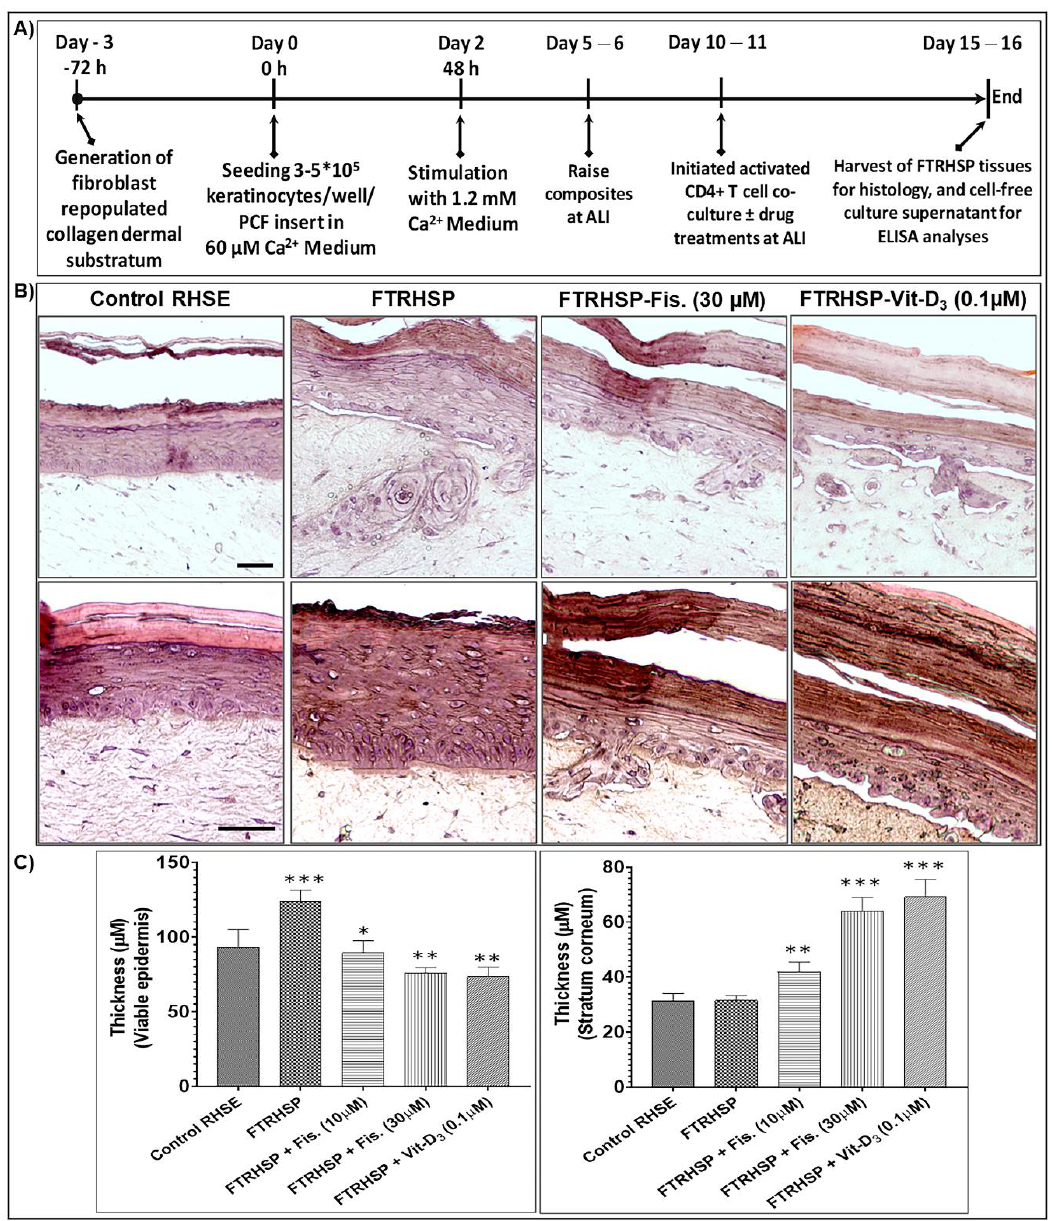
Figure 7. Fisetin modulated psoriasis-like features in a three-dimensional (3D) full-thickness reconstituted human skin model of psoriasis (FTRHSP). ( A ) Protocol for the establishment/generation of the 3D full-thickness reconstituted human skin model of psoriasis (FTRHSP), and for the evaluation of the therapeutic effects of compounds (fisetin or known control agent vitamin D 3 (Vit-D 3 )) on psoriasis-like pathologic features. Candidate compounds were added on top of the tissue after five days of lifting to the air-liquid interface and at the same day in wells containing preactivated or not T lymphocytes at the base of the engineered reconstructs and co-cultured. These were continually cultivated for an additional five days in the presence or absence of these agents prior to harvest, with media replenishment every alternate day. ( B ) Photomicrographs of modified Mayers’s hematoxylin- and eosin-stained control RHSE, FTRHSP, and FTRHSP treated with/without fisetin/Vit-D 3 reconstructs, scale bar; top panel 20 µ M, and bottom panel 50 µ M. ( C ) Bar graphs showing quantification of changes in the thicknesses of; the viable epidermis (left panel), which significantly decreased in treated group vs. FTRHSP, and stratum corneum (right panel), which significantly increased in treated group